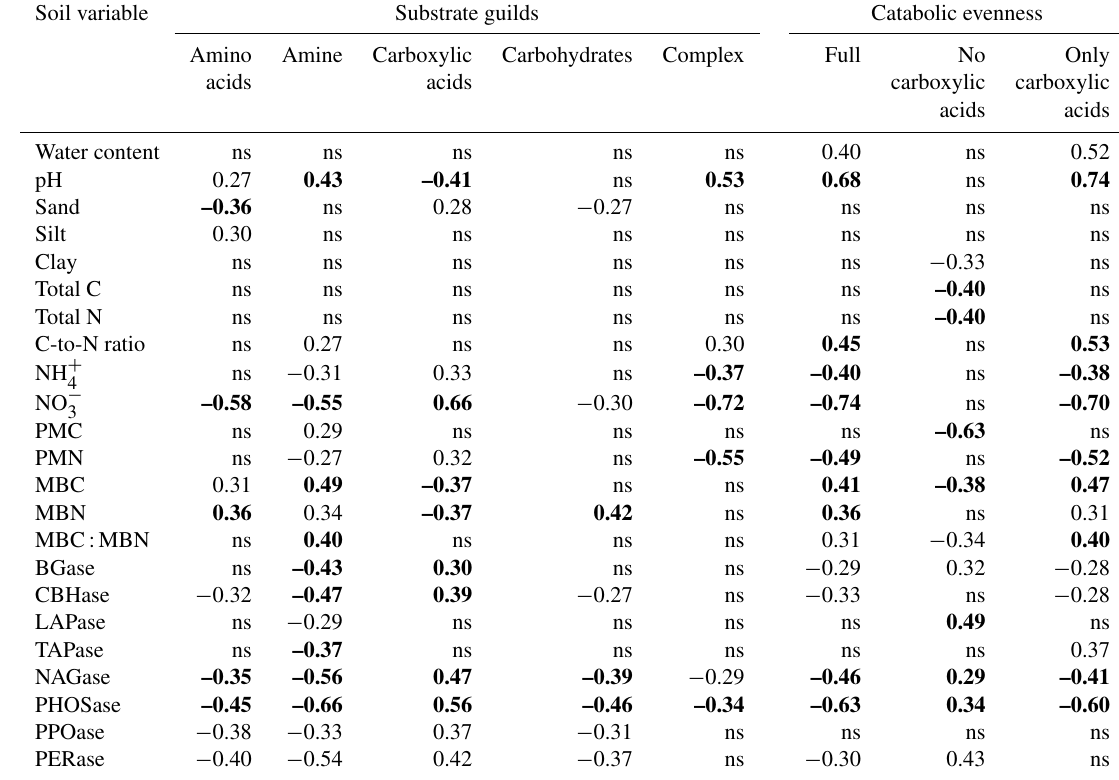
Table 5. Pearson correlation coefficients between soil properties and community-level physiological profile (CLPP) parameters. Soil